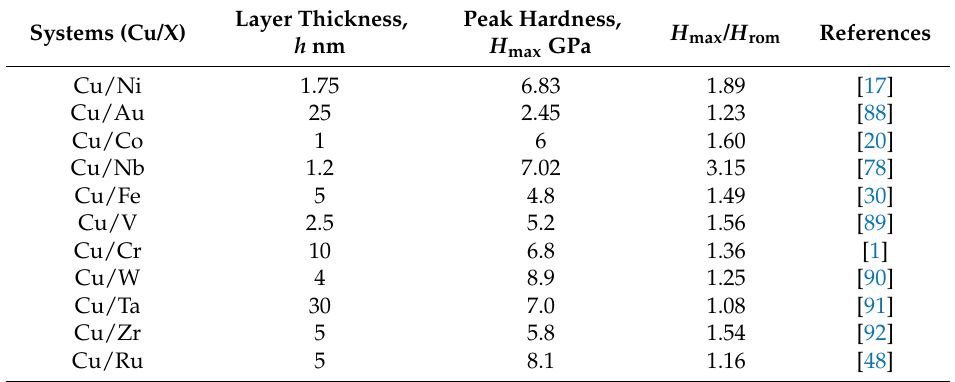
Table 2. Peak hardness H max and hardness enhancement H max / H rom for a variety of Ag/X multilayers. Layer Systems (Ag/X) Layer Thickness, Peak Hardness,